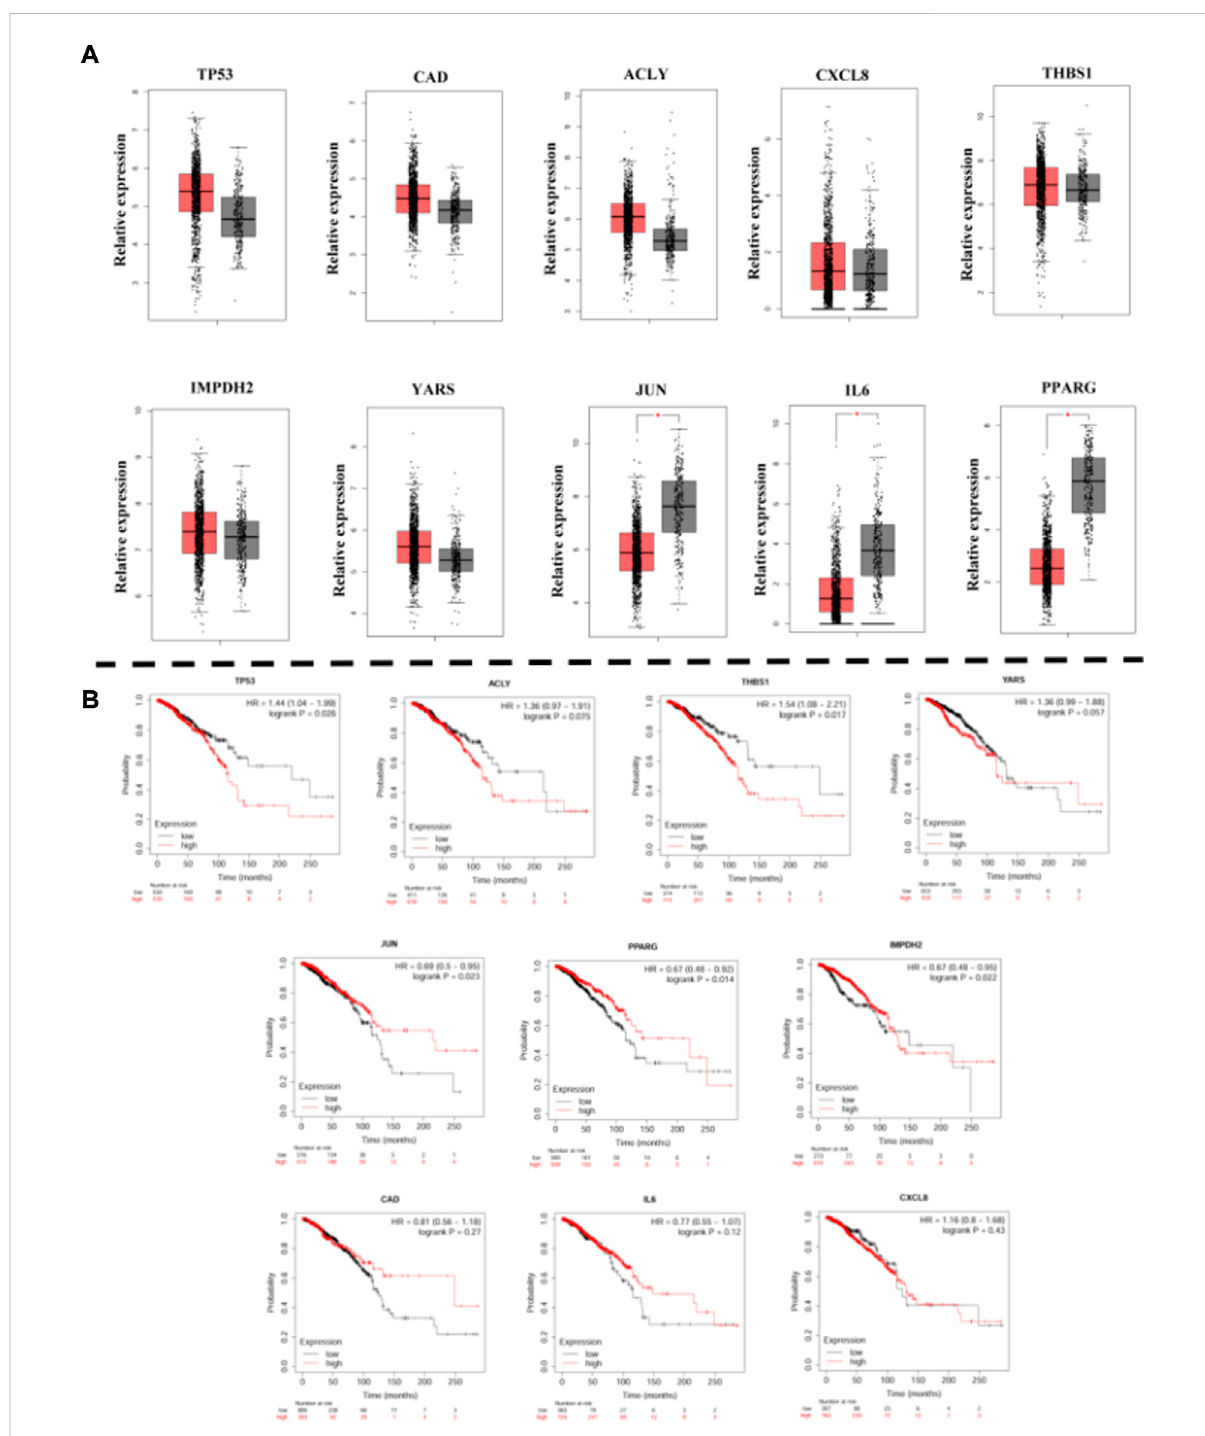
FIGURE 6 (A) : The expression of hub genes in BREAST samples of TCGA. (B) : Kaplan-Meier curves displaying OS of